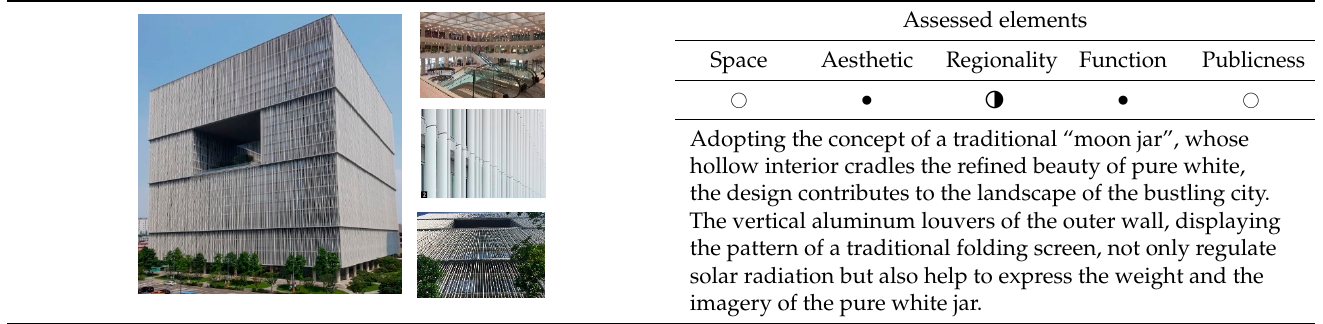
Table 5. Decorative facades: Amorepacific headquarters (David Chipperfield/Haeahn Architecture 2017).